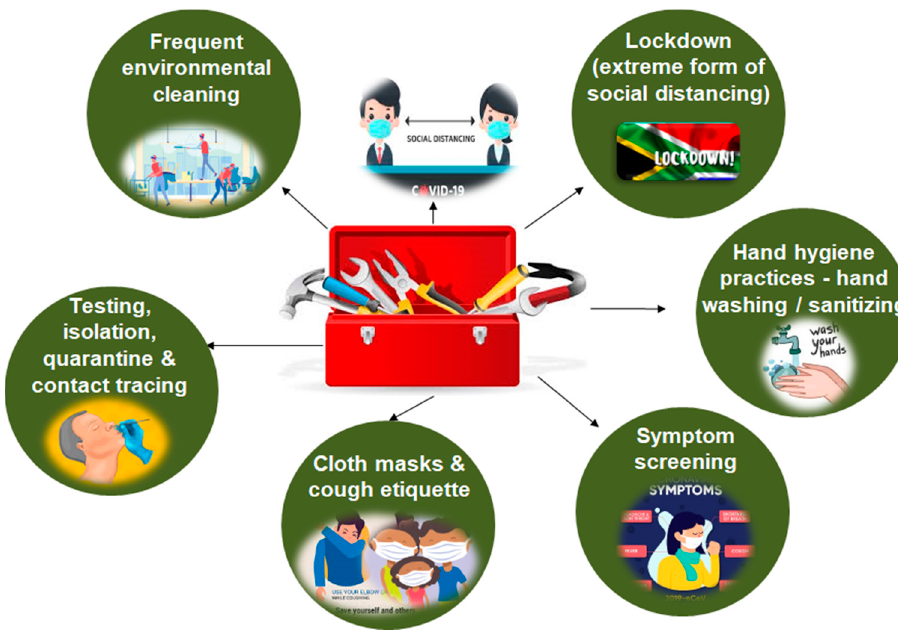
Figure 2. Safety protocols and etiquettes during COVID-19.